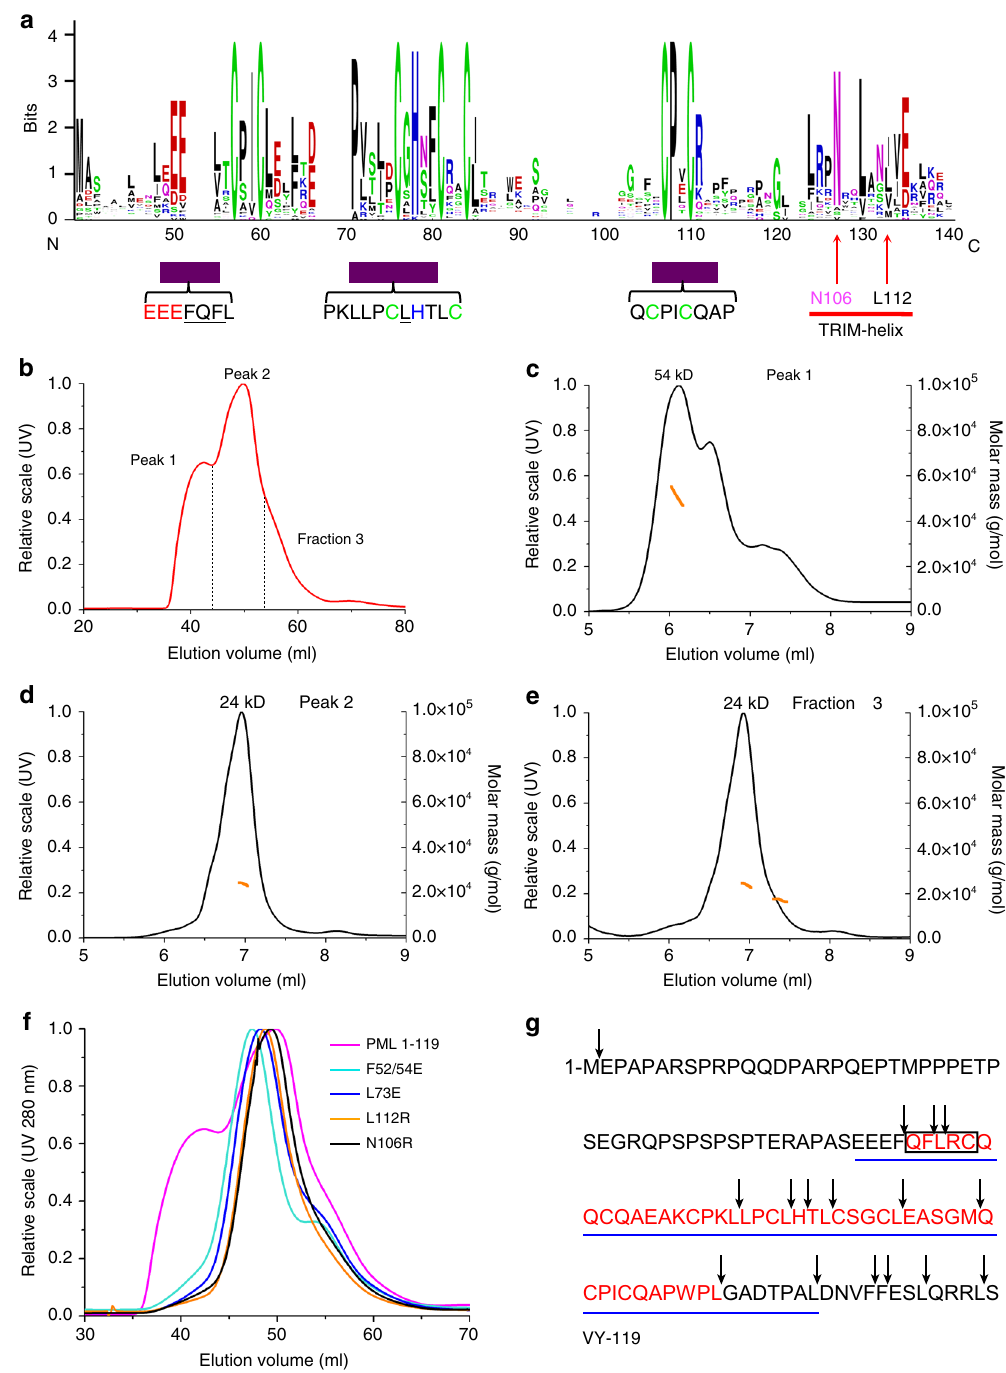
Fig. 3 Biochemical evidence for RING tetramer formation. a Consensus sequence among TRIM RINGs (Top). PML conserved sequences are highlighted with purple boxes (Bottom). The conserved TRIM dimeric interface is highlighted with a red line. The Asn and Ile/Leu residues (red arrows) mediate dimeric assembly of other TRIMs. b Gel fi ltration analysis of recombinant PML RING 1 – 119 . Two elution peaks and a last fraction, designated as Peak 1, 2 and fraction 3, respectively. c – e SEC-MALS reanalysis of Peak 1 ( c ), Peak 2 ( d ) and fraction 3 ( e ) derived from previous gel fi ltration ( b ). Black curve, the elution pro fi le in UV. Orange curve, the estimated molecular weight. The theoretical molecular weight of PML RING 1 – 119 is 13.1 kDa. Peak 1 sample displayed distinct peaks that correspond to the tetramer (54 kDa), dimer and monomer in the solution. Peak 2 and fraction 3 samples primarily exhibit RING dimer (24 kDa). f Gel fi ltration of WT RING 1 – 119 and its mutants. g Recombinant PML RING 1 – 119 was subjected to chymotrypsin digestion (Supplementary Figure 5). Arrows indicate the chymotrypsin sites and amino acids indicated in red correspond to the protected fragment, as determined by mass spectrometry and N- terminal sequencing (Box). RING 49 – 104 sequences analyzed by X-ray crystallography are underlined with a blue